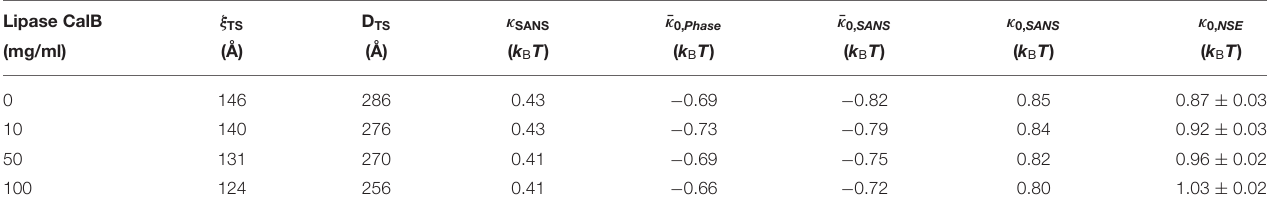
TABLE 2 | Parameters obtained from small angle neutron scattering (SANS) and phase diagram measurements: Correlation length and domain size determined from SANS experiments and deduced bending rigidity κ SANS , saddle-splay modulus and neutron spin echo (NSE) measurements as lined out in Holderer et al. (2013).